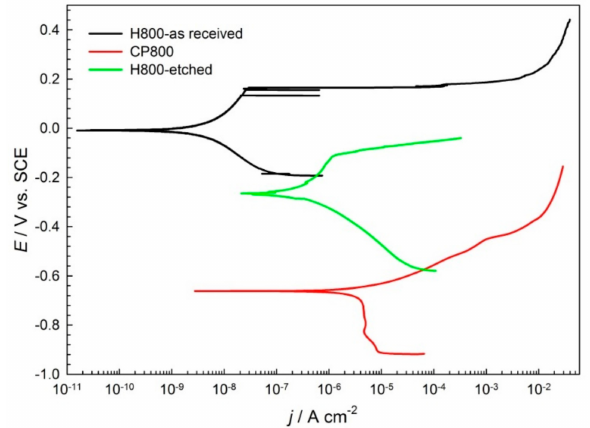
Figure 7. Potentiodynamic scans for the H800-as-received, H800-etched, and CP 800 steels in a 0.5 M NaCl solution, scan rate 1 mV /